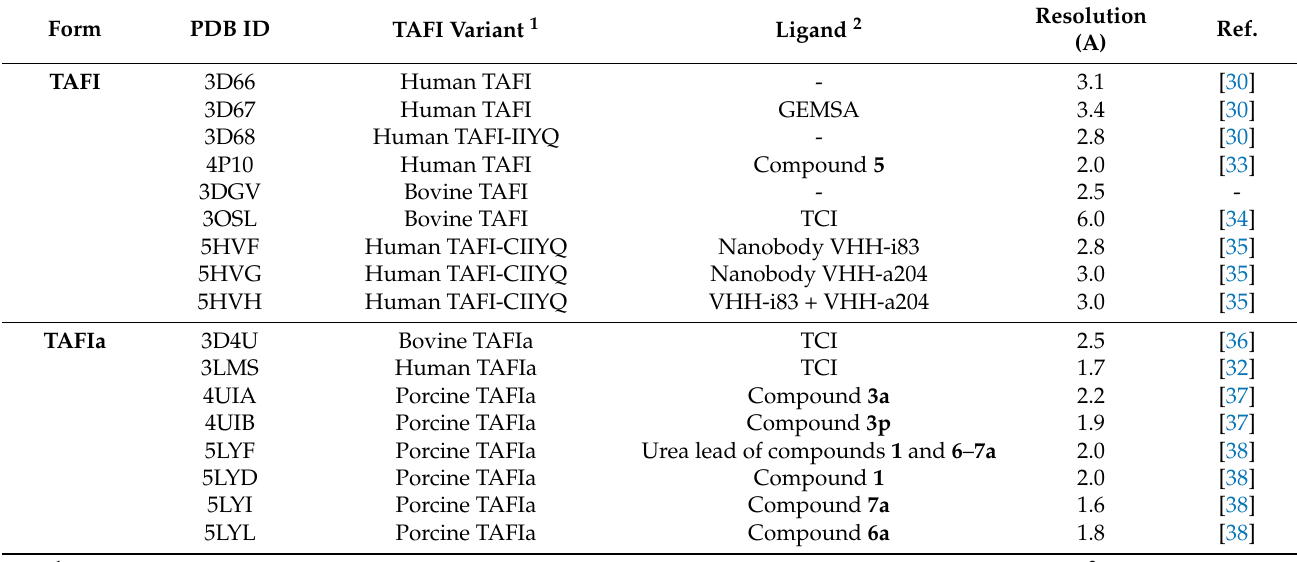
Table 1. List of X-ray crystallographic structures containing TAFI or activated TAFI (TAFIa) in the Protein Data Bank (PDB).